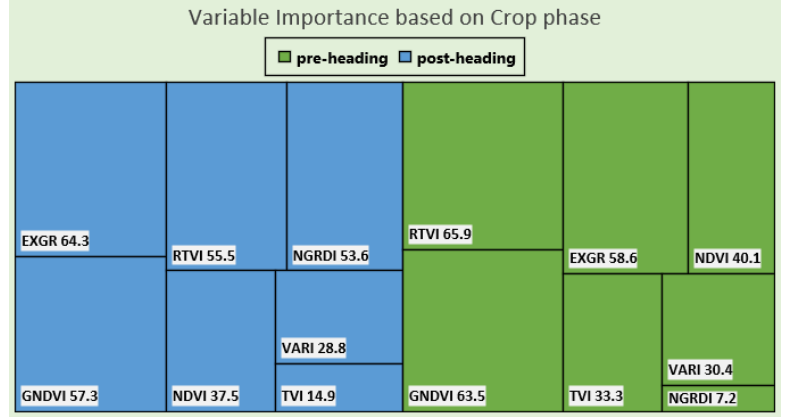
Figure 11. Importance scores for predictor variables. The importance scores of predictors are summarized considering all locations and model types.